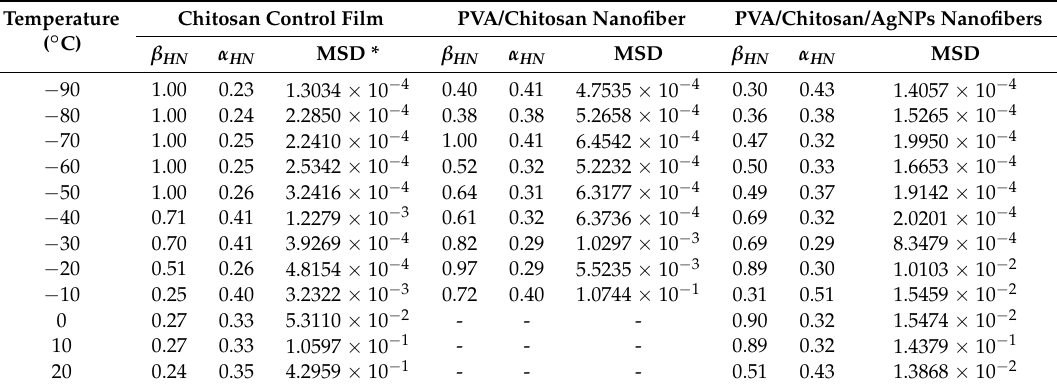
Table 1. Relaxation peak shape parameters extracted from the H-N model fitting to Process I spectra for all samples at different